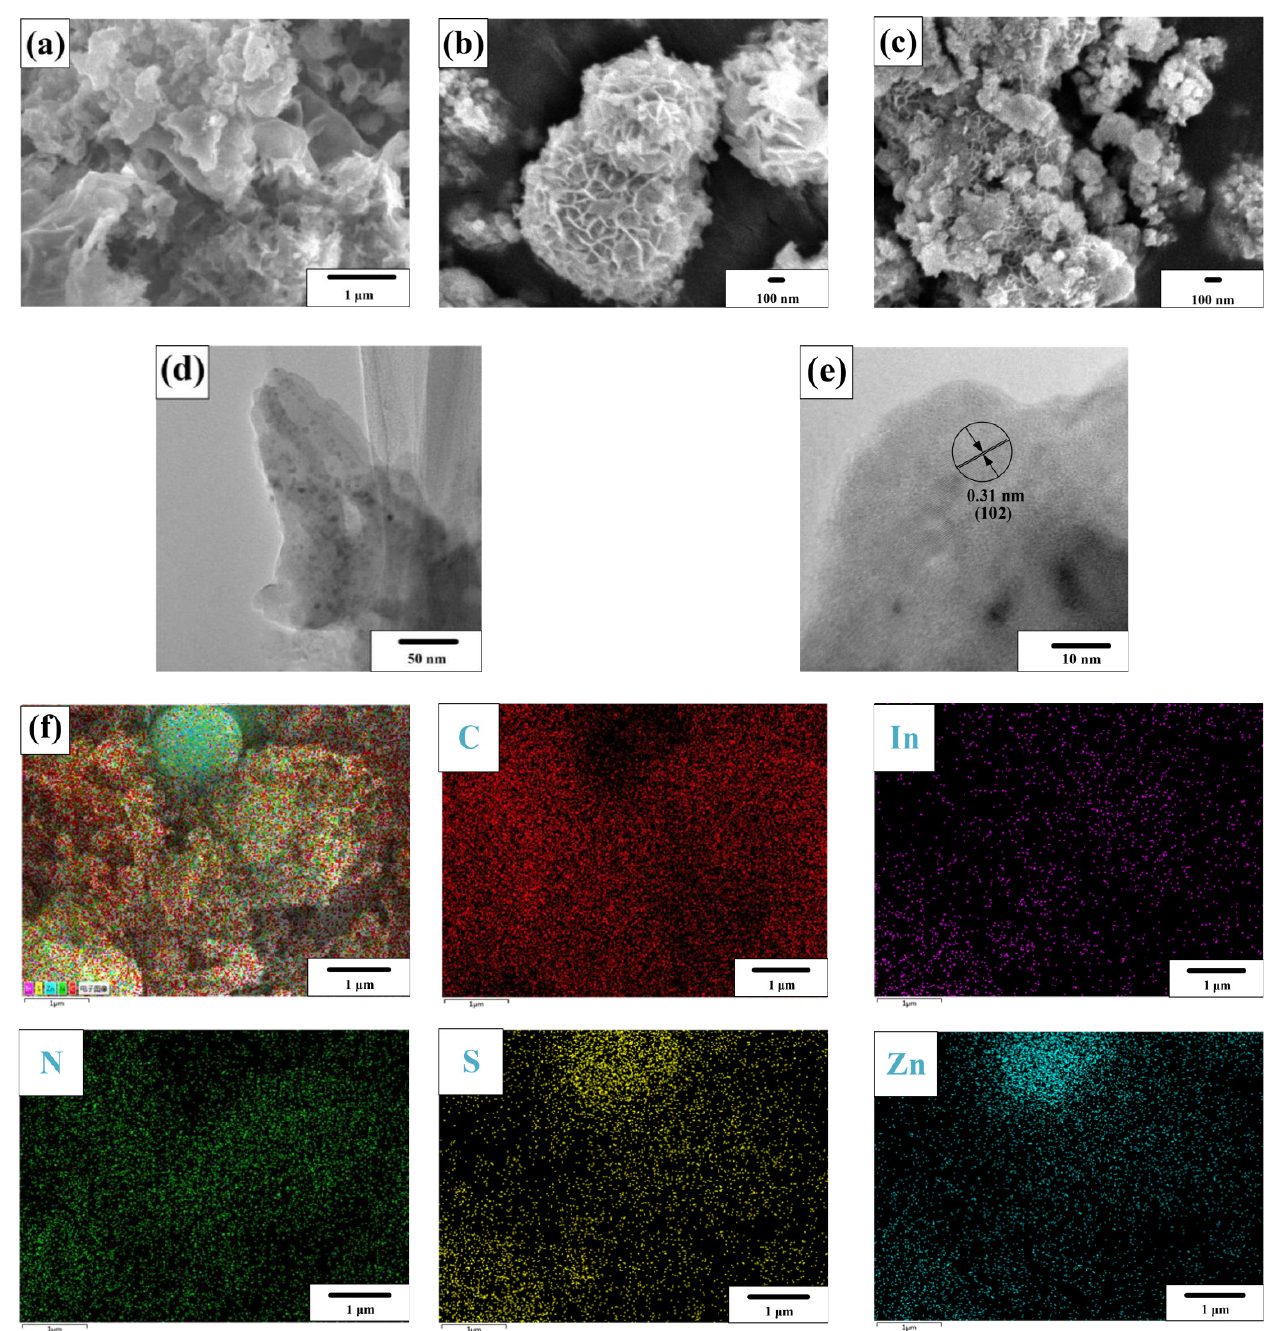
Figure 2. SEM images of ( a ) g ‐ C 3 N 4 , ( b ) Zn 3 In 2 S 6 , ( c ) 80ZIS/CN, ( d , e ) TEM images of 80ZIS/CN, and ( f ) EDS elements mapping of 80ZIS/CN.